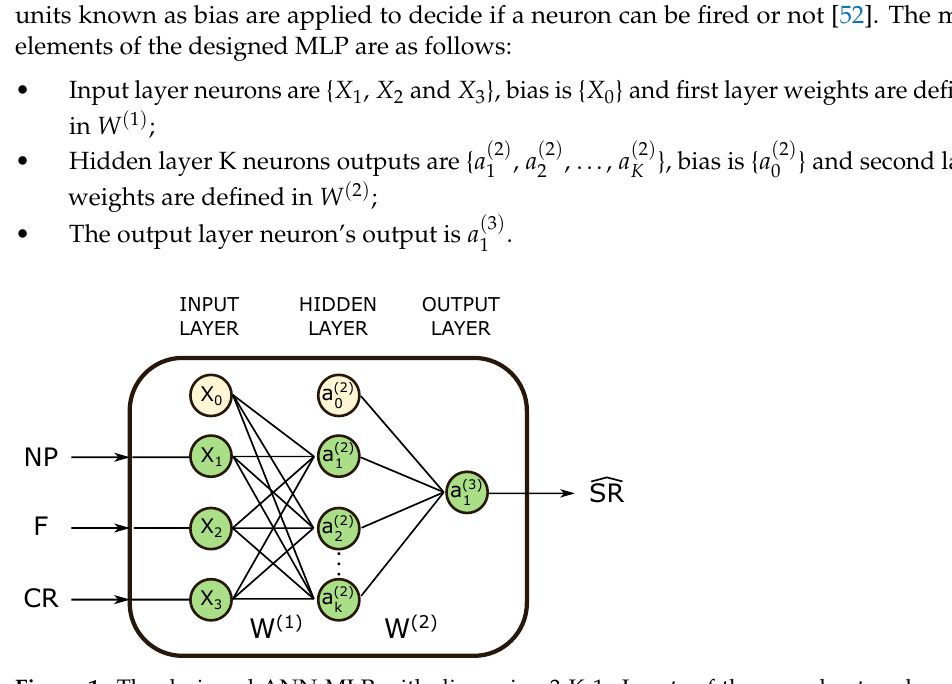
Figure 1. The designed ANN-MLP with dimension 3-K-1. Inputs of the neural network are DE parameters NP, F and CR, and the output is the prediction of SR expressed as (cid:99) SR . The hidden layer neuron number (K) is obtained in the ANN training